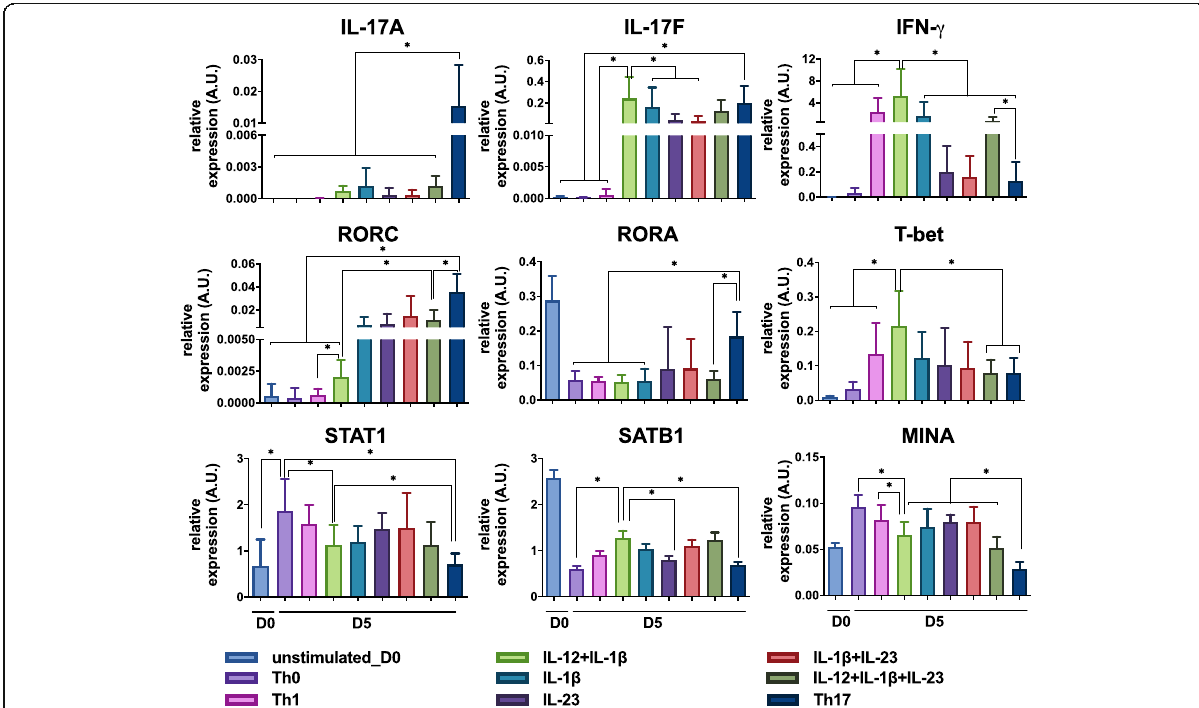
Fig. 3 Quantification of transcription of model internal components by RT-PCR. Human naive T cells were differentiated for five days in the presence of polyclonal activation (anti-CD3/anti-CD28 beads). Cells were cultured in the presence of different cytokine inputs: proTh1 (IL-12), IL- 1 β , IL-23, IL-12 + IL-1 β , IL-1 β + IL-23, IL-12 + IL-1 β + IL-23, proTh17 (IL-1 β + IL-6 + IL-23 + TGF- β ). Cells exposed only to polyclonal stimulation were considered as Th0. RNA extraction of differentiated cells was performed and transcripts were then quantified by RT-PCR. Gene expression was normalized to the housekeeping genes HPRT1, B2M and RPL34. Relative expression of IL-17A, IL-17F, IFN- γ , RORC, RORA, T-bet, STAT1, SATB1, MINA are depicted. Graphs represent mean ± SD, N = 5 and * denotes p < 0.05 (Wilcoxon